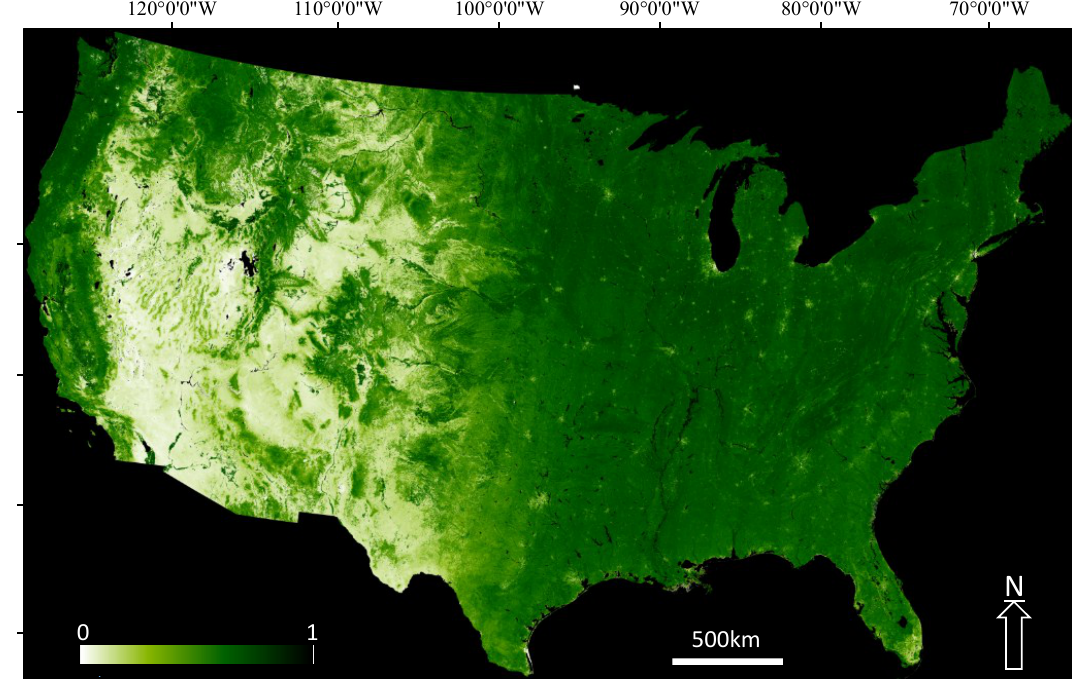
Figure 6. Landsat-7/ ETM+ NDVI composite of the conterminous US in